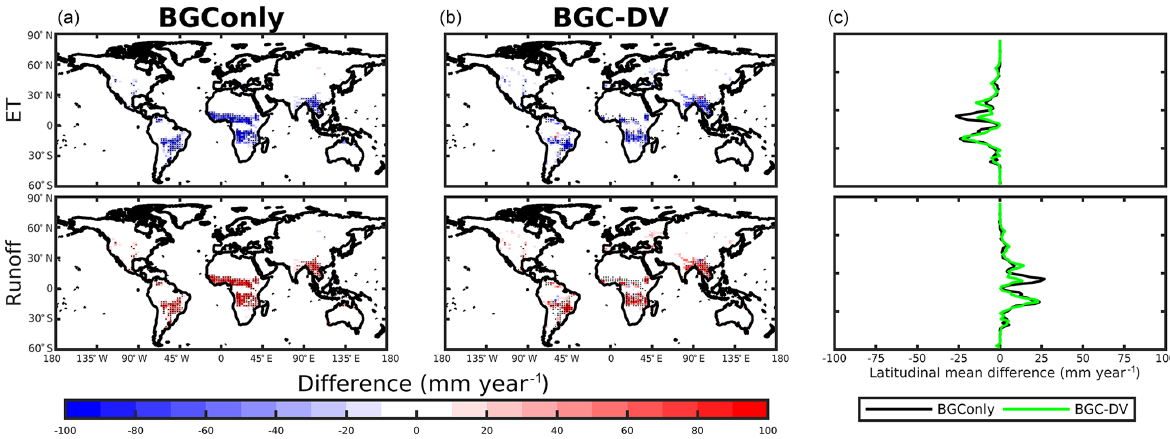
Figure 8. Differences in evapotranspiration (ET) and runoff due to fire in BGConly (BGConly-F minus BGConly-NF; a ) and BGC-DV (BGC-DV-F minus BGC-DV-NF; b ). Hashed areas indicate that the difference passed the Student’s t test at the 0.05 significance level. Latitudinal mean differences are plotted in (c) . Table 5. Annual mean water budgets for ground evaporation (GE), canopy evaporation (CE), canopy transpiration (CT), evapotranspiration (ET), and total runoff (RO) and the difference between the one with fire and the one without fire (i.e., BGConly-F minus BGConly-NF and BGC-DV-F minus BGC-DV-NF) in 10 3 km 3 yr − 1 . Asterisk (*) indicates that the difference passed the Student’s t test at the α = 0 . 05 significance